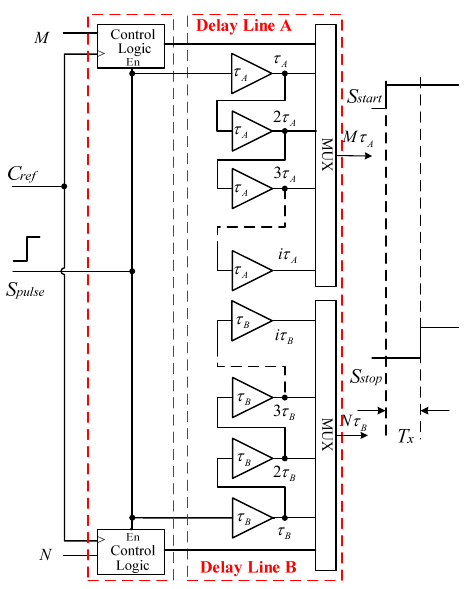
Figure 2. Schematic of a digital ‐ to ‐ time converter (DTC) based on a Vernier delay line.